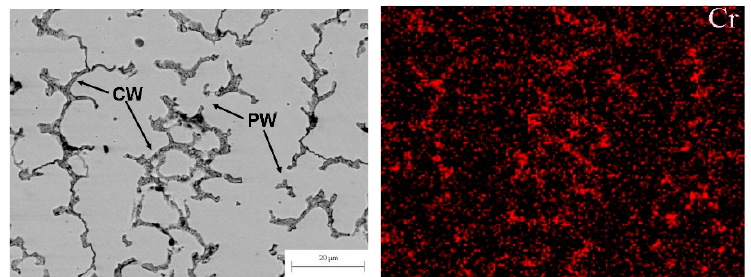
Figure 7. ( left ) SEM micrograph of the plasma cladded CoCrFeNiMn HEA coating. Arrows with the symbol CW show the completely wetted GBs. Arrows with the symbol PW show the partially wetted GBs. ( right ) EDS map of chromium in the middle part of the CoCrFeNiMn coatings prepared at plasma arc current of 70 A. Micrographs are reprinted with permission from ref. [13]. Copyright 2021 MDPI.